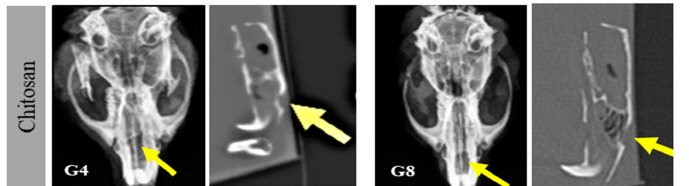
Figure 3. Radiographic and tomographic findings in the surgical area. The bone defect (yellow arrows) was not completely closed in any of the studied groups, and no bone deformity was observed. Abstainer animals (Ab): G1—control/abstainer (C/Ab), G2—collagen/abstainer (Co/Ab), G3—elastin/abstainer (El/Ab), and G4—chitosan/abstainer (Ch/Ab). Alcoholic animals (Al): G5—control/alcoholic (C/Al), G6—collagen/alcoholic (Co/Al), G7—elastin/alcoholic (El/Al), and G8—chitosan/alcoholic (Ch/Al).